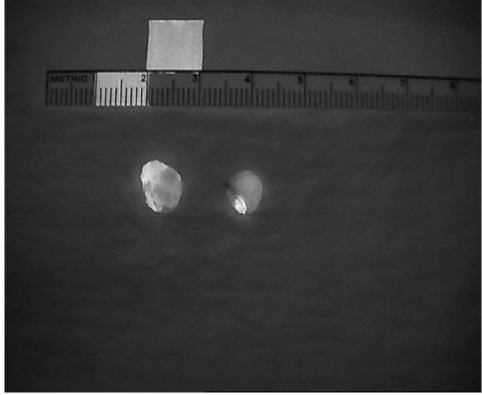
Figure 6. Heterogeneous fluorescent patterns in two resected parathyroid adenomas .